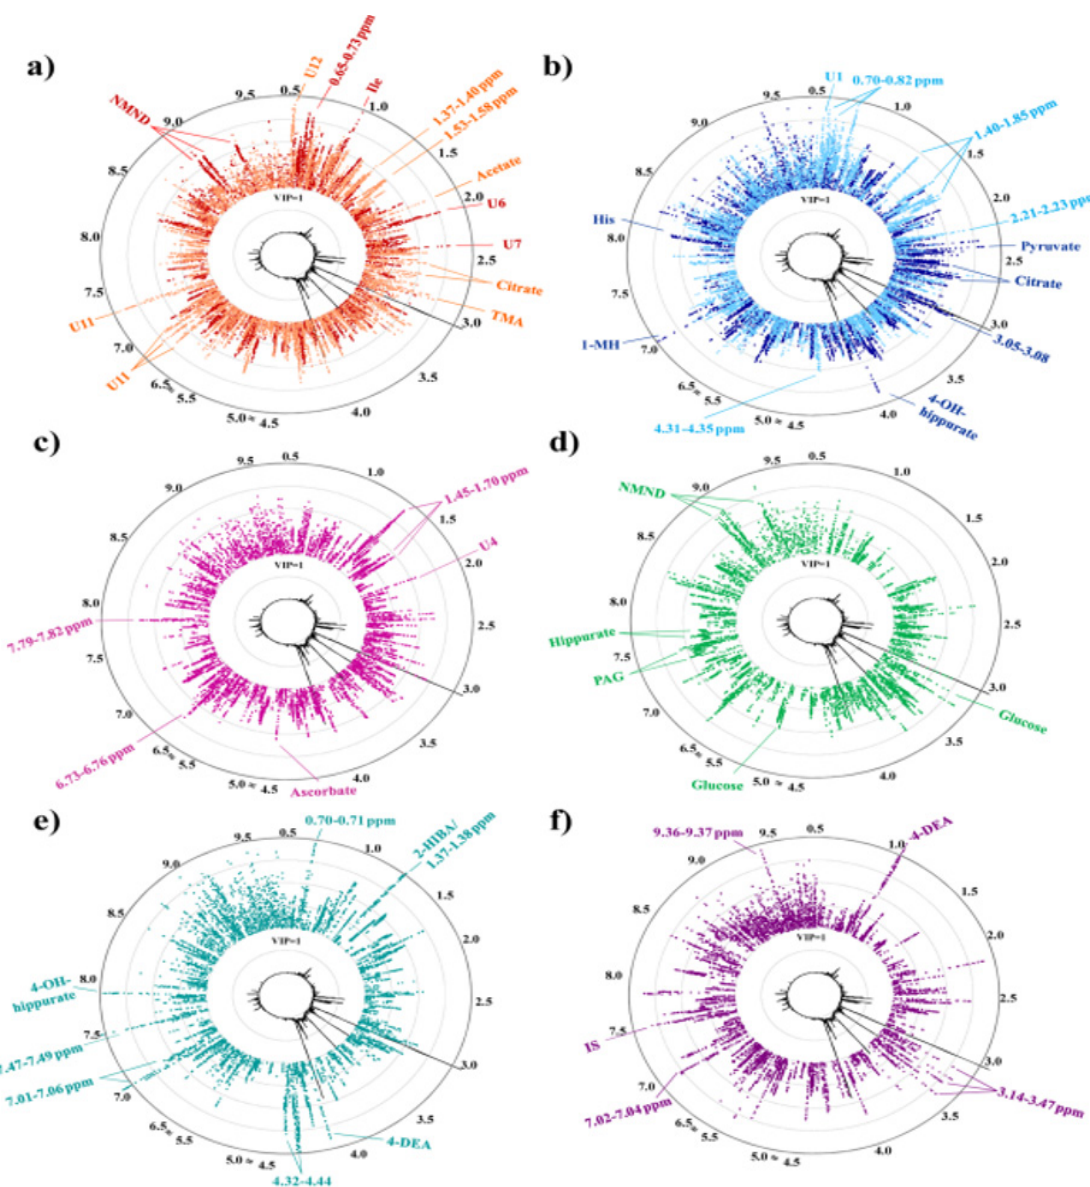
Figure 5. NMR metabolite signatures in VIP wheel presentation acquired for each prenatal disorder. Each dot represents a spectral data point. Average of HNMR spectrum of controls shown in inner circle with parts per million scale in outer black circle: ( a ) FM malformed foetuses = red, overlapped with CNS malformations = orange; ( b ) CD = dark blue, overlapped with T21= light blue; ( c ) pre-PTD = pink; ( d ) pre-diagnostic GDM = green; ( e ) pre-IUGR = turquoise; ( f ) pre-PE = purple. [44].